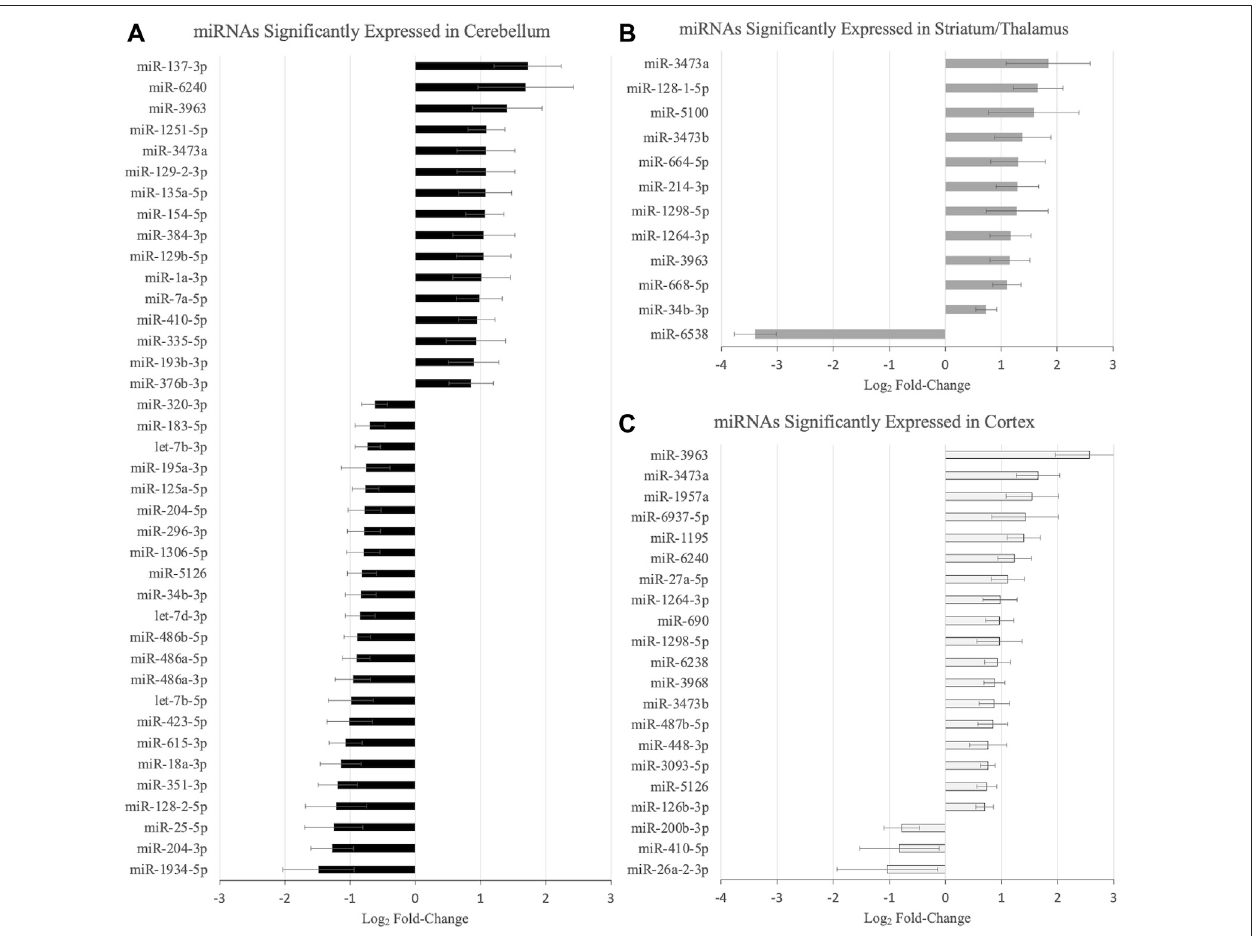
FIGURE 1 | MicroRNAs with signi fi cant differential expression at 30 min after hypoxic-ischemic brain injury in the (A) cerebellum, (B) striatum/thalamus, and (C) cortex ( n = 4/group for each region). Signi fi cance de fi ned by fold-change > 1.5, p value and/or false discovery rate < .05, and average count per million reads > 10. Error bars represent standard error of the